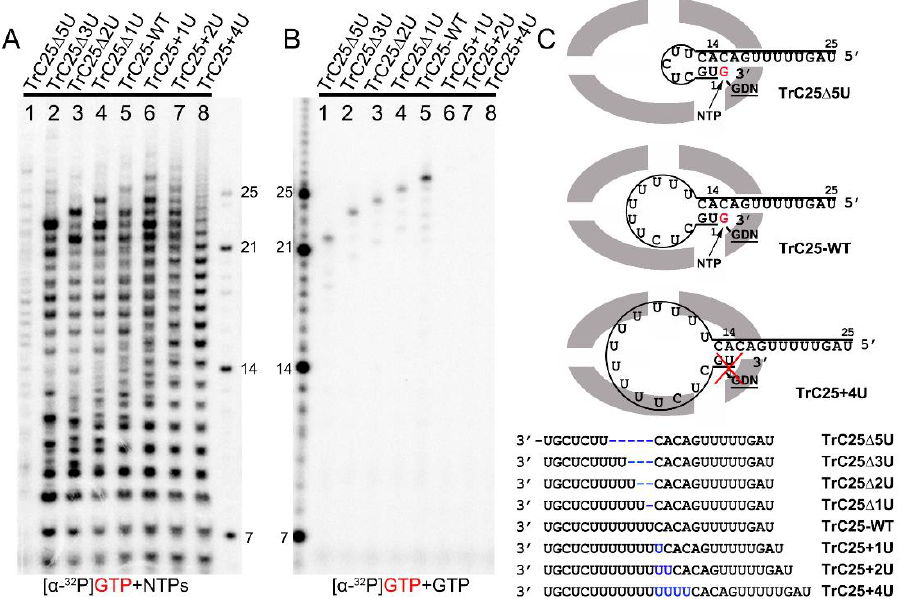
Figure 2. Impact of hairpin loop size on de novo RNA synthesis and back-priming-based 3′ terminal extension. ( A ) De novo RNA synthesis of TrC25-WT and mutants with different numbers of Us at the position 6-12 by the RSV polymerase with NTPs (ATP, CTP, and UTP each at 1.25mM and GTP at 50 μM with 5 μCi of [α - 32 P] GTP). ( B ) The 3′ terminal extension of wt and mutants of RNA templates TrC25 with GTP only. GTP at 50 μM with 5 μCi of [α - 32 P] GTP was used in the reaction mixtures. ( C ) Sequences and secondary structures of the RSV wt and mutants of TrC25 RNA templates. Residues GDN are the catalytic residues in the RdRp domain that are responsible for RNA polymerization. The red cross indicates no activity towards TrC25+4U. Red G or GTP indicates radiolabeled GTP. The blue Us indicate additional UTP residues that were added to the wt TrC25 template, while the blue dashes indicate Us that were deleted from the wt TrC25 template.